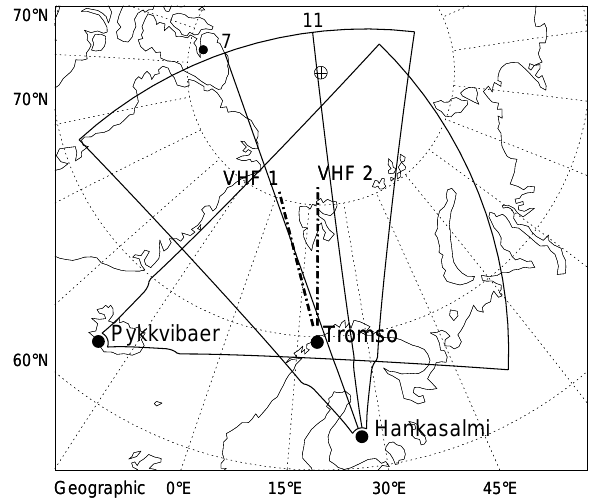
Fig. 1. Map depicting the fields-of-view of the CUTLASS Finland and Iceland East radars. Beams 7 and 11 of the Finland radar are indicated explicitly, as solid lines. In addition, the two beams of the EISCAT VHF radar are illustrated as thick broken lines. The small filled circle and the cross within a circle represent the posi- tions of the magnetic and geographic poles, respectively, whereas larger filled circles indicate the locations of the radars